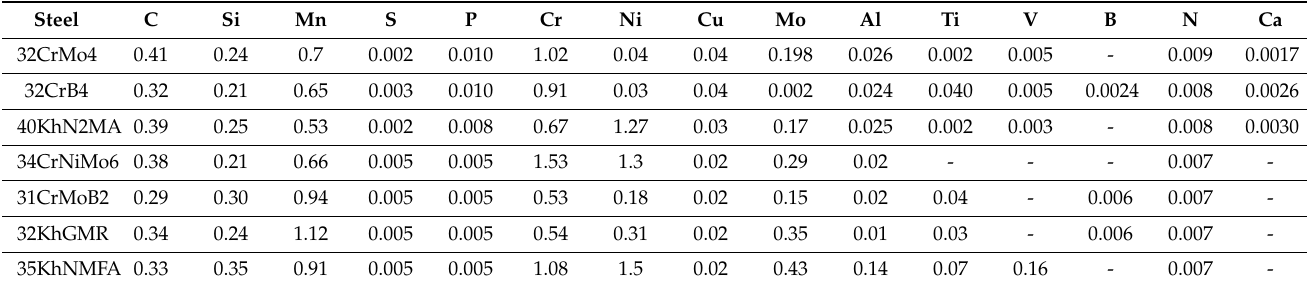
Table 1. Chemical composition of the studied steels